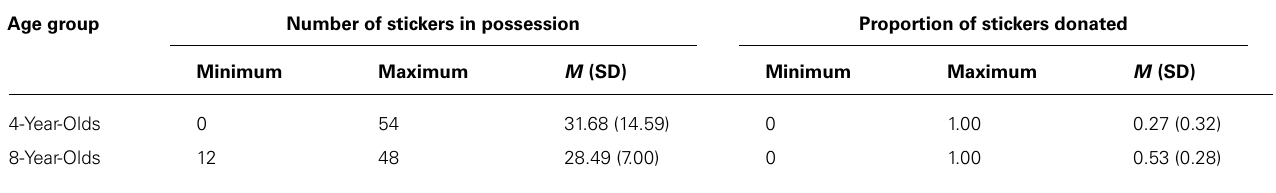
Table 1 | Descriptive statistics by age group for number of stickers children possessed at start of donation task and proportion of stickers donated. Age group Number of stickers in possession Proportion of stickers donated Minimum Maximum M (SD)